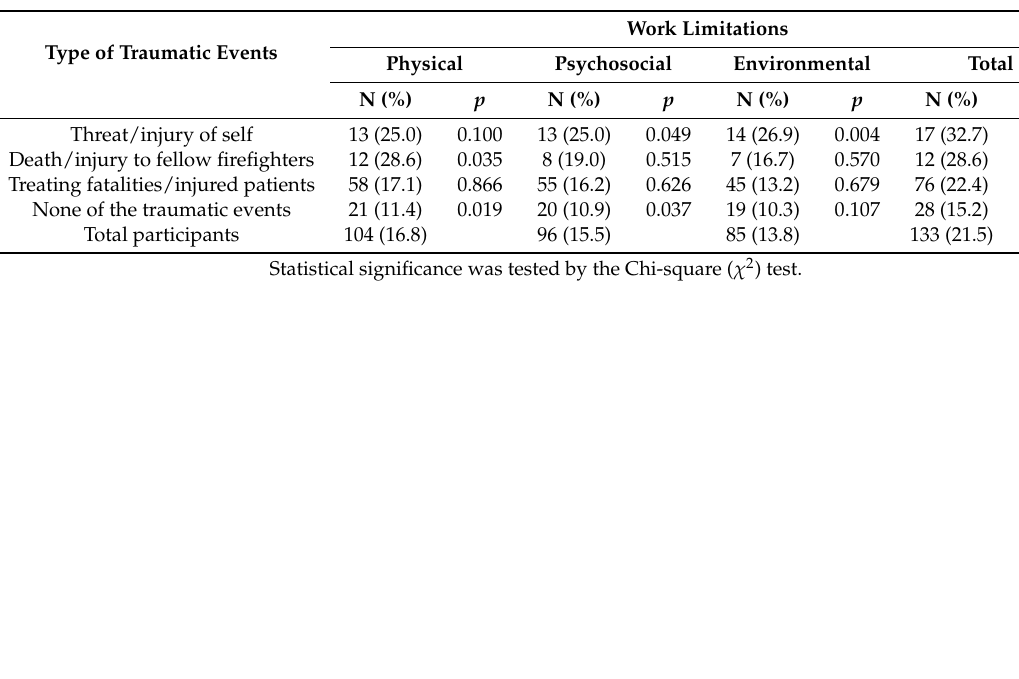
Table 2. Percentage of firefighters with some or more work limitations caused by work-related traumatic